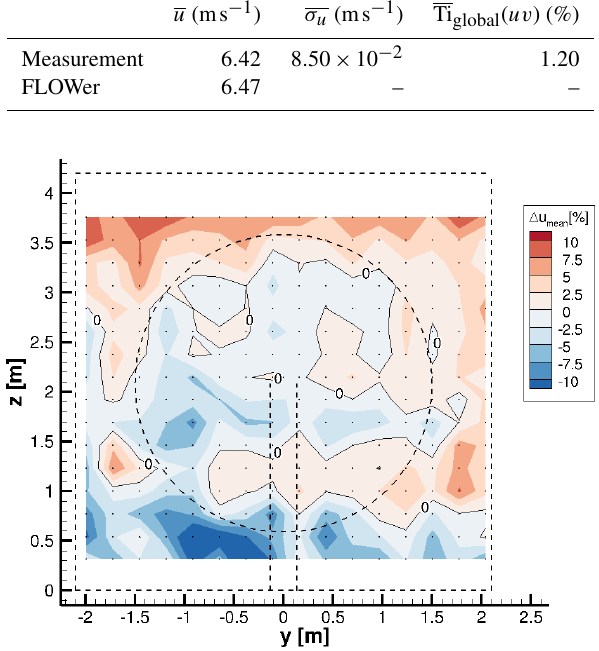
Figure 9. Relative velocity difference between measurement and simulation with regard to the undisturbed reference inflow velocity of 6 . 5ms − 1 , 0 . 43 d upstream of the rotor plane. The dashed lines illustrate the wind tunnel and the turbine. Isolines show 0% devia- tion. The dots show the discrete evaluation